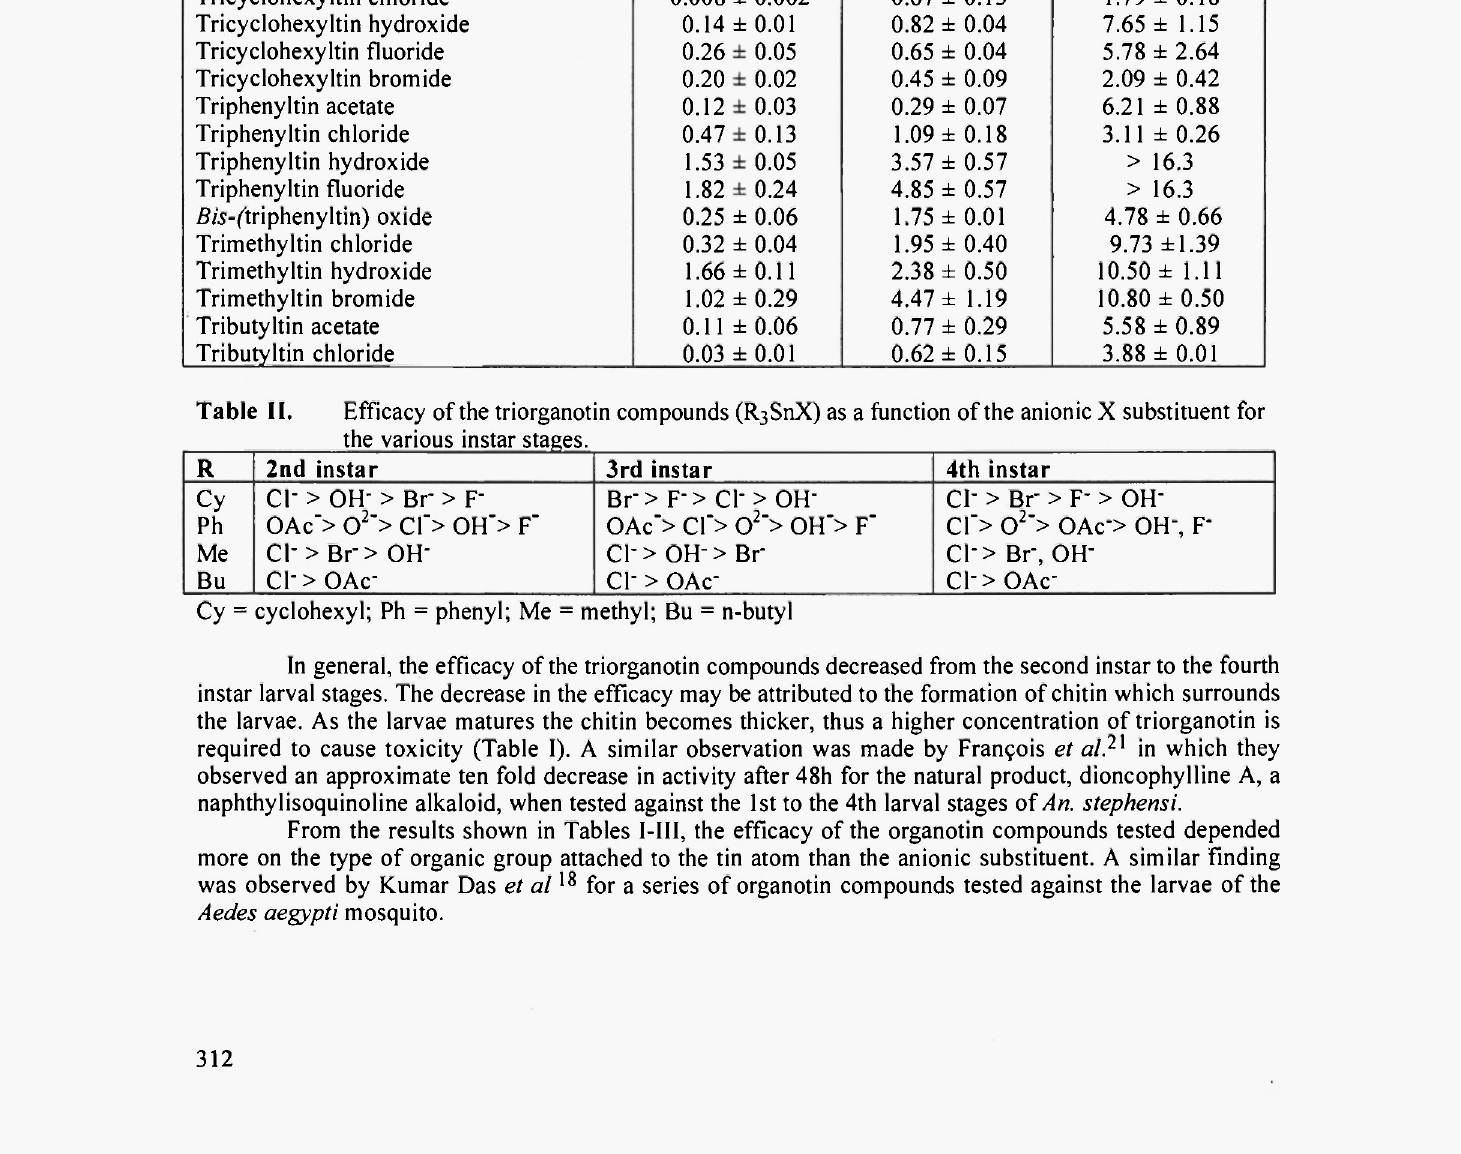
Table 1. The LCsn (μΜ) values of various triorgantin compounds on Anopheles stephensi after 24 hours. Compound